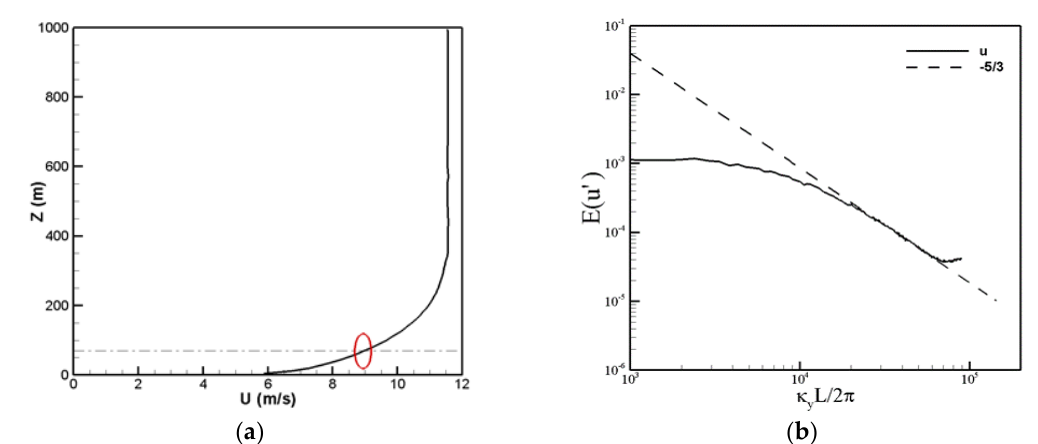
Figure 2. Instantaneous streamwise velocity contours.